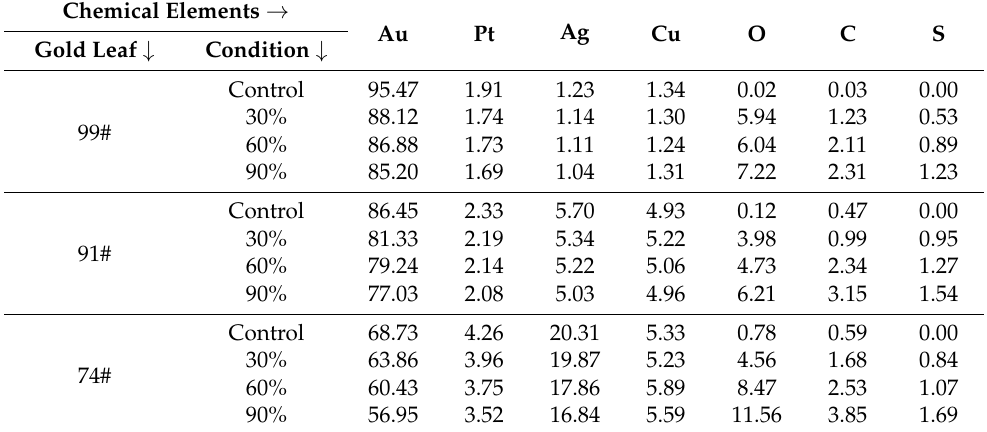
Table 2. Average elemental composition of the control and corroded samples in selected regions. Chemical Elements